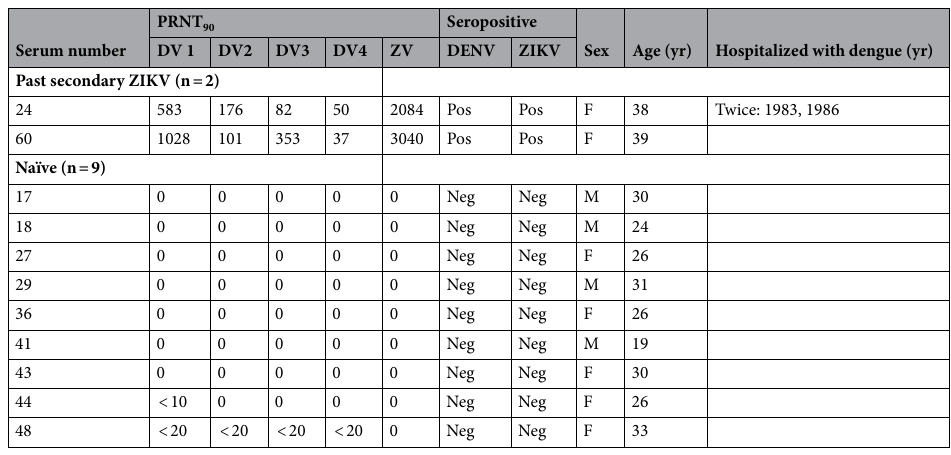
Table 3. Serostatus and neutralizing antibody profile of participants. DV DENV, F female, m male, Neg seronegative, Pos seropositive, PRNT